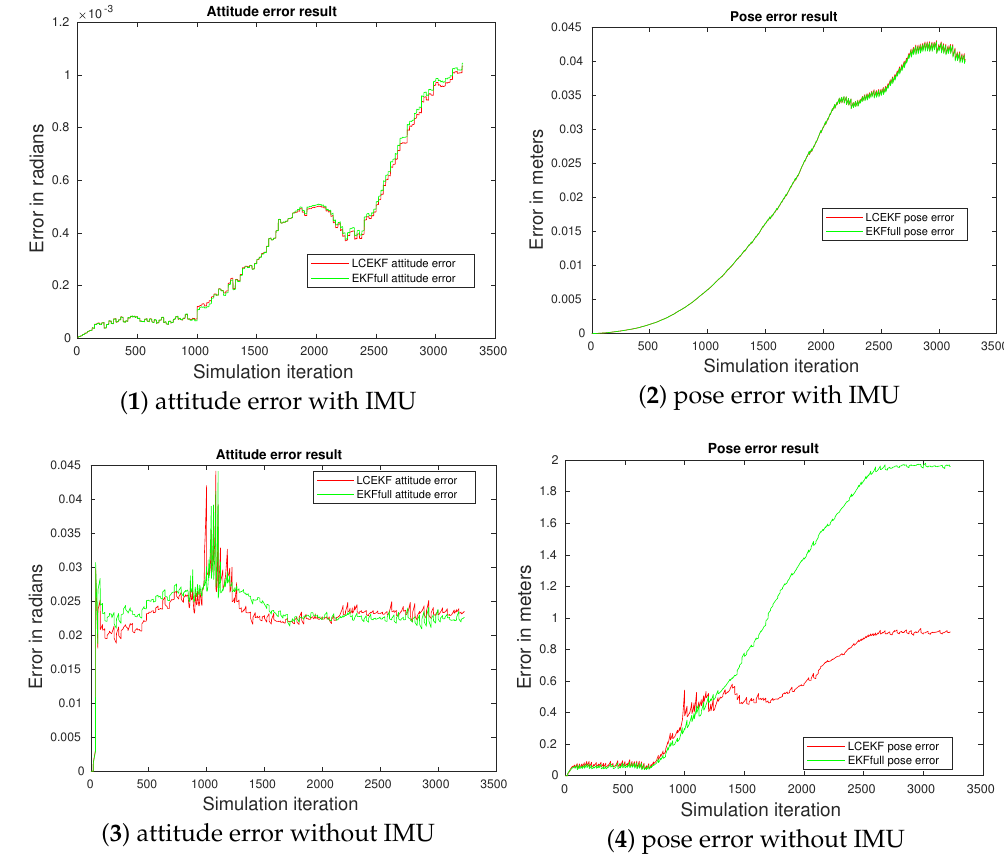
Figure 13. SLAM with chock noise (Case iii): methods’ comparison. Figures ( 1 ) and ( 2 ) represent the MSE of the pose and attitude estimation over 10 executions for the three methods while using the IMU for prediction. All the methods performed in the same way. Figures ( 3 ) and ( 4 ) represent the MSE of the pose and attitude estimation over 10 executions for the three methods while using a constant velocity model for prediction (no proprioceptive sensor). It can be seen that without the use of the IMU, both the LCEKF and EKFfull had a positioning error that increased over time (classical observed drift). Nevertheless, the LCEKF is more